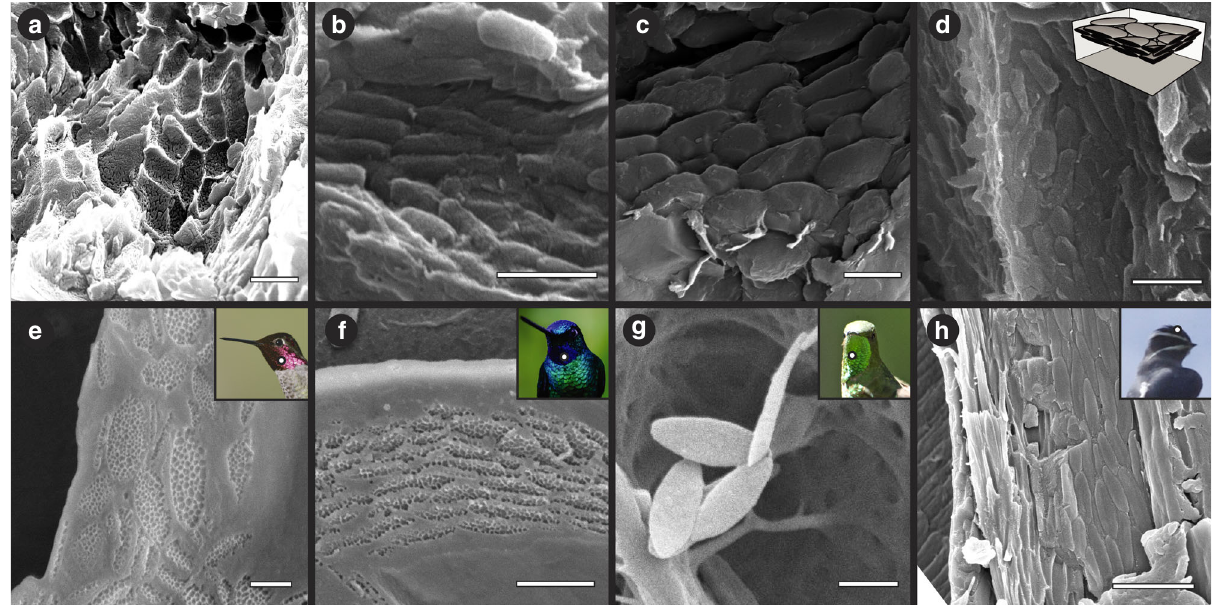
Fig. 5 Platelet-like nanostructures in Caihong juji and melanosomes in iridescent extant feathers. a – d Fossilized nanostructures from Caihong feathers preserved as molds in a neck feather ( a ) and three-dimensional preservation in a neck feather, with SEM stage rotated 45° to show 3D platelet morphology ( b ), a back feather with SEM stage at 0° ( c ) and a neck feather showing nanostructure packing ( d ); e Anna ’ s hummingbird ( Calypte anna ) showing overlapping melanosomes within a feather barbule; f white-tailed starfrontlet ( Coeligena phalerata ) showing stacking and interior morphology (air bubbles) of melanosomes in a feather barbule; g black-tailed trainbearer ( Lesbia victoriae ) showing exterior surface and morphology of isolated melanosomes in a feather barb; h moustached treeswift ( Hemiprocne mystacea ) showing densely packed melanosomes in the barbule of a crown feather. Inset in d illustrates 3D stacking of platelet-shaped nanostructures. All scale bars: 1000 nm. Photo credits: Chao PC ( e , license CC BY-2.0, https://creativecommons.org/ licenses/by/2.0/legalcode), Misty Vaughn f , Lip Kee ( g , license CC BY-SA 2.0, https://creativecommons.org/licenses/by-sa/2.0/legalcode), Lip Kee ( h , CC BY-SA 2.0,